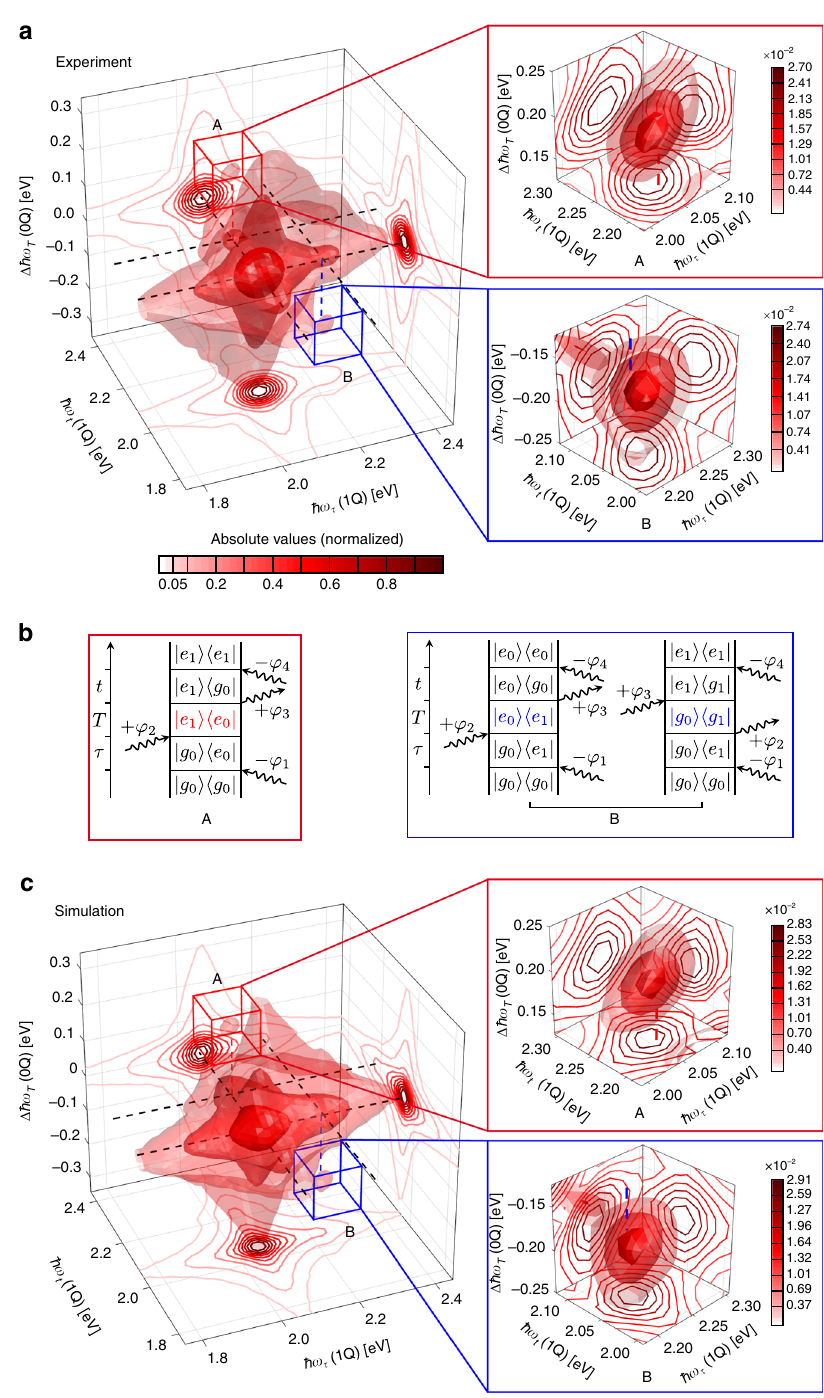
Fig. 3 Fourth-order rephasing 1Q – 0Q – 1Q 3D spectrum of TIPS – TAP 2 − in THF. a Experimental and c simulated rephasing 1Q – 0Q – 1Q 3D spectra, shown in absolute values. The energies of the main absorption band at 2.06 eV and the progression band at 2.23 eV are indicated as dashed black lines in the Δ ℏ ω = 0 plane as a guide for the eye. Red and blue dashed vertical lines mark positive and negative shifts of 0.17 eV, respectively, along the 0Q axis T Δ ℏ ω T . Isosurfaces are drawn at 2.3, 9.0, and 35% of the maximal signal amplitude. Contour lines of the 2D projections of the spectral solids are drawn at linearly spaced levels of the normalized signal amplitude with an additional contour line at 0.05. The spectral volumes inside the red and blue cuboids, which are centered around peaks A and B are isolated and shown on the right. There, isosurfaces are drawn at 50, 70, and 90% of the isolated maximal signal amplitudes whereas the color bars indicate the signal levels (normalized to the highest absolute value of the respective full 3D spectrum) for each contour line. b Double-sided Feynman diagrams that describe the peaks A (red) and B